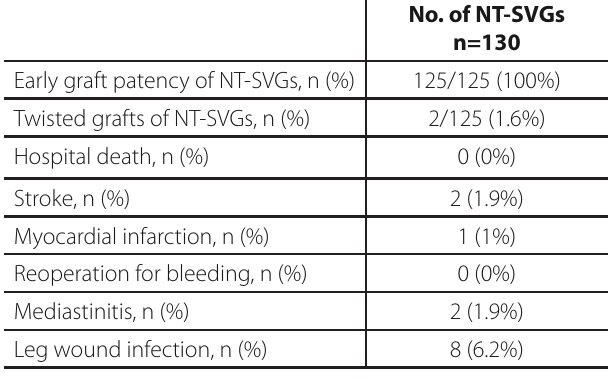
Table 3. Early outcomes of CABG using